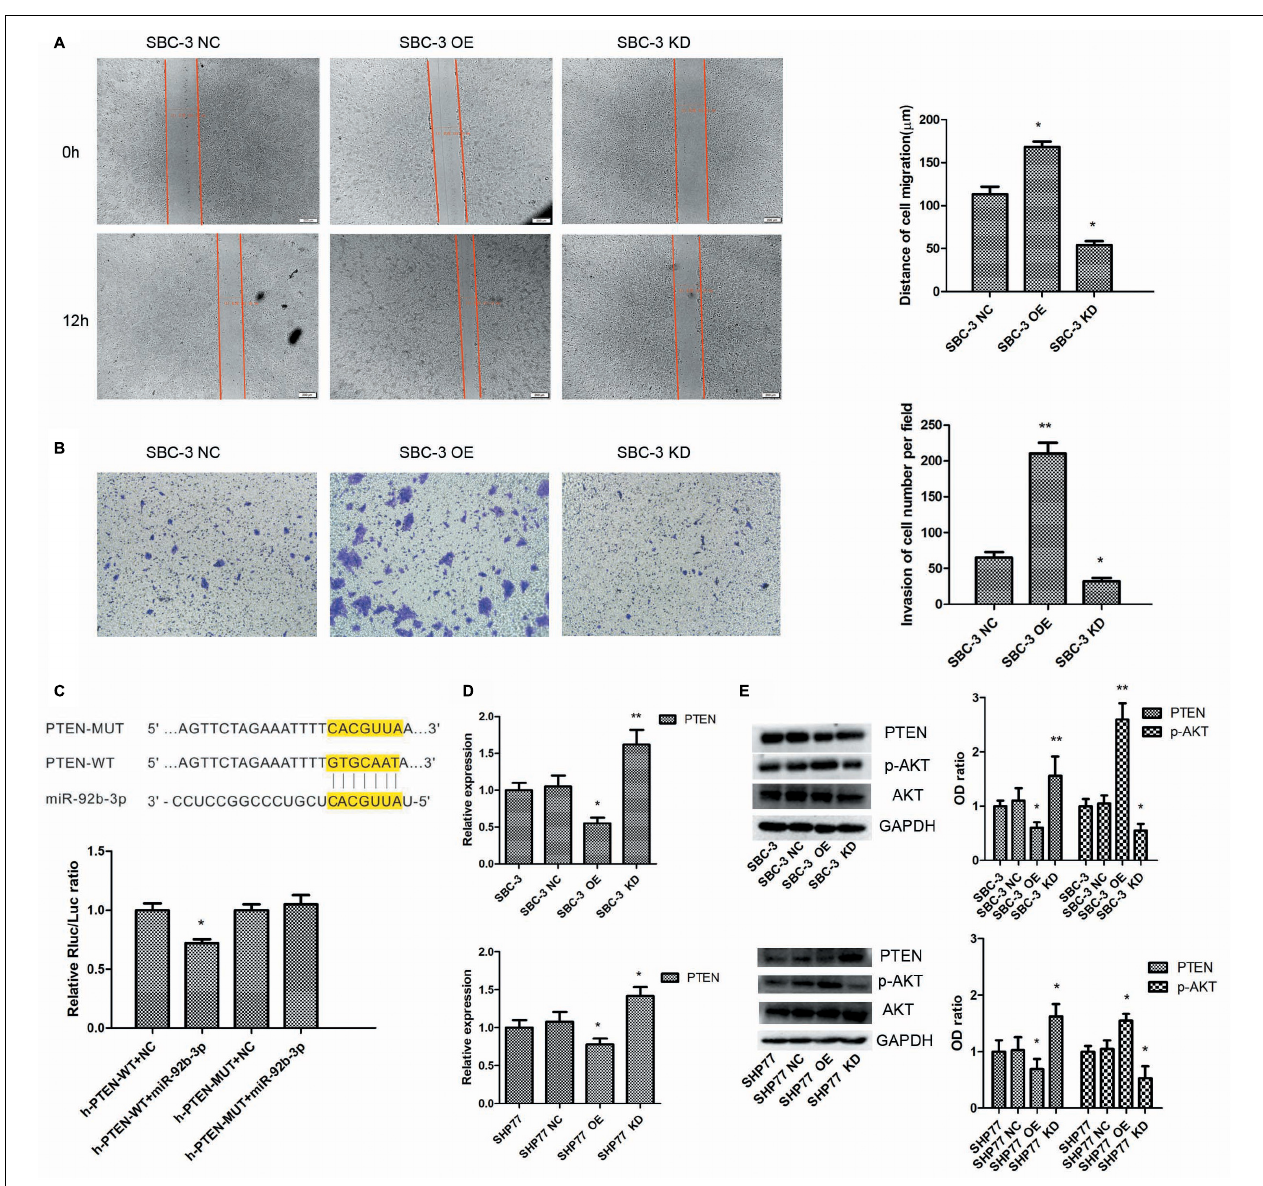
FIGURE 3 | MiR-92b-3p promotes SCLC chemoresistance by targeting the PTEN/AKT pathway. (A,B) MiR-92b-3p promotes SBC-3 cell migration and invasion. (C) The highly conserved miR-92b-3p binding motif in the 3 (cid:48) -UTR of PTEN. MiR-92b-3p only suppressed the luciferase activity in cells expressing the wild-type 3 (cid:48) -UTR of PTEN. (D) qRT-PCR data showed that PTEN expression was increased in SCLC KD cells but decreased in SCLC OE cells. (E) PTEN, AKT, and p-AKT levels were detected by western blot. The p-AKT level was significantly decreased in SCLC KD cells, whereas the PTEN level was increased in SCLC OE cells. (A,B,D,E) data points were determined three times. SCLC, small cell lung cancer. * P < 0.05, ** P < 0.01.